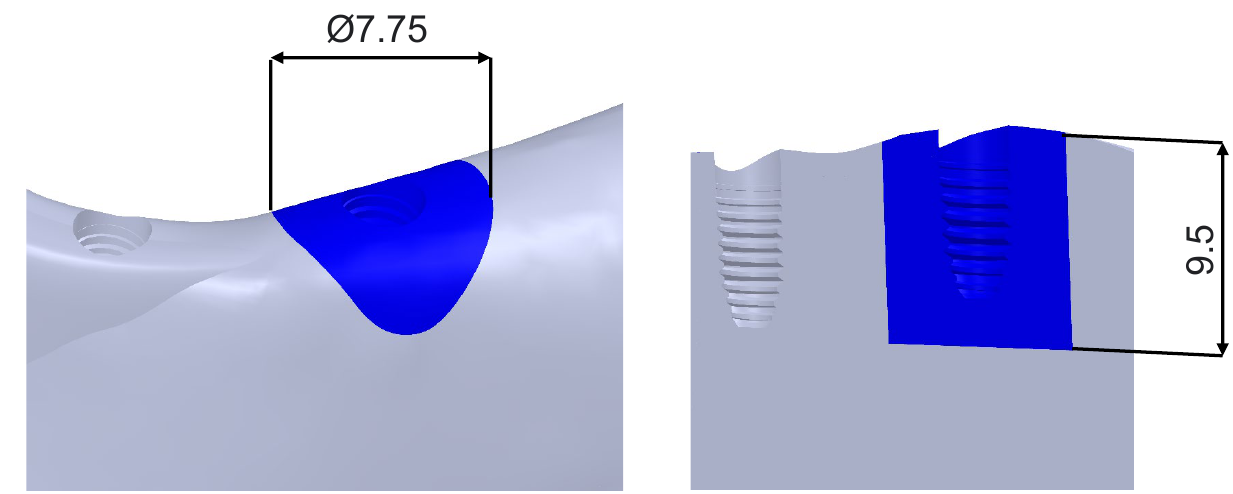
Figure 6. Maximum equivalent von Mises stress values. Blue shades—cases with implants be- tween foramina. Green shades—cases with the 2 implants posterior to the distal of the foramen.